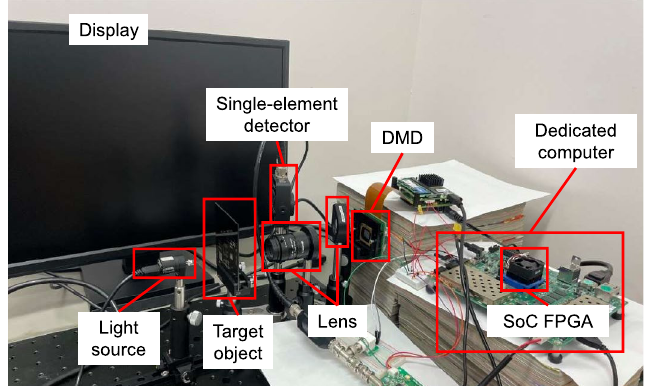
Figure 4. Optical system used in the experiment. The configuration and arrangement of the optical system is the same as in Fig. 1.